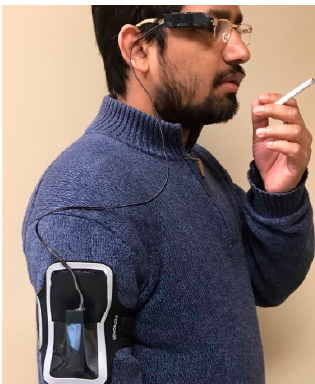
Figure 8. Egocentric camera attached to the eye-glass temple to captured details of smoking event.